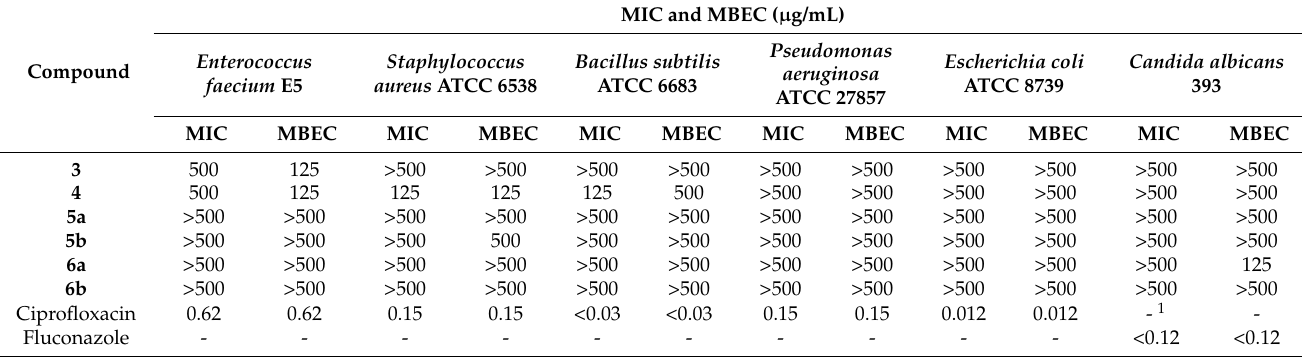
Table 4. The MIC and MBEC values ( µ g/mL) obtained for the tested compounds using microdilution method.